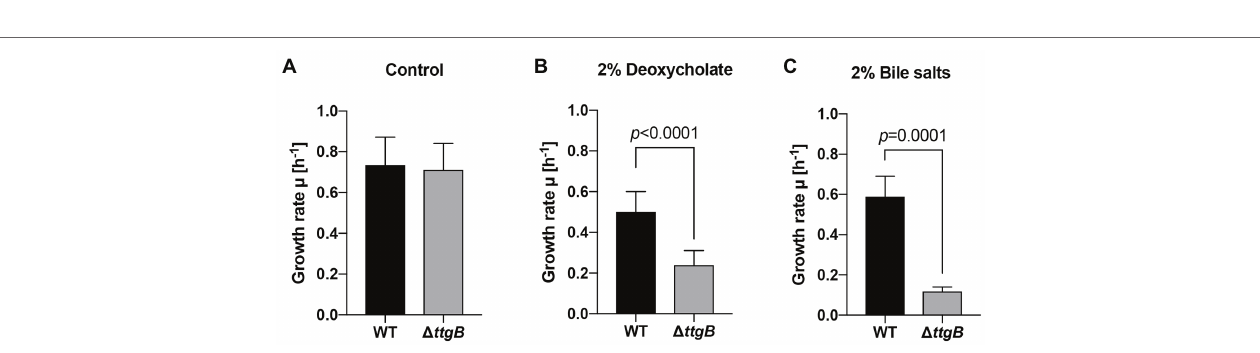
FIGURE 6 | Bipyridyl toxicity in the absence of a functional TtgABC is dependent on metal chelation. Bacterial growth of the wild type strain (A–C) and the ΔttgB mutant (D–F) was assessed in KB medium supplemented with (A,D) 50–100 μ M CuSO 4 , (B,E) 50–100 μ M FeCl 3 or (C,F) both metal salts. To that end, washed cells from an overnight culture were resuspended in water and used to inoculate 100 μ l of KB medium in a 96-well plate. Growth curves (OD600) were recorded using a CLARIOstar reader. All experiments were performed a minimum of three times.